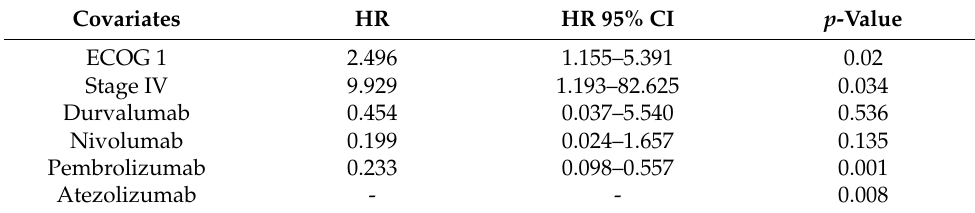
Table 5. Multivariate